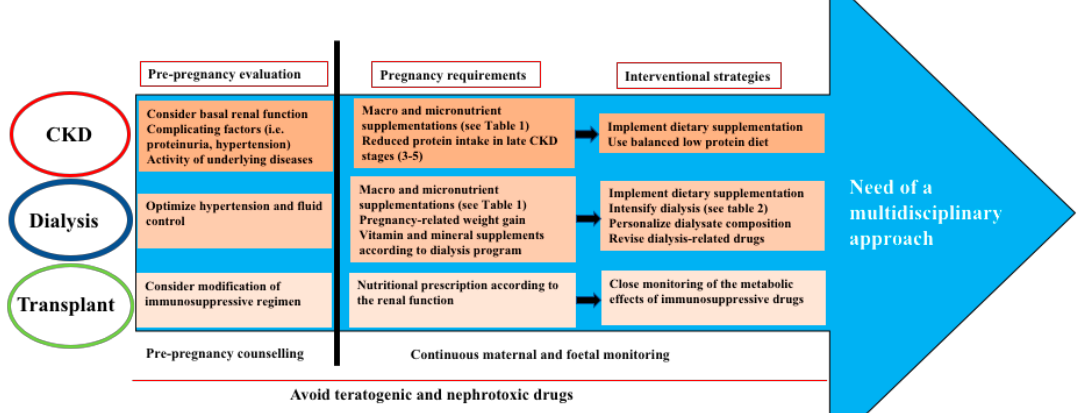
Figure 1. Main clinical issues and recommendations in the nutritional management of pregnant women with chronic kidney disease (CKD), on dialysis and after renal transplant. The multidisciplinary approach should include psychological and social support.